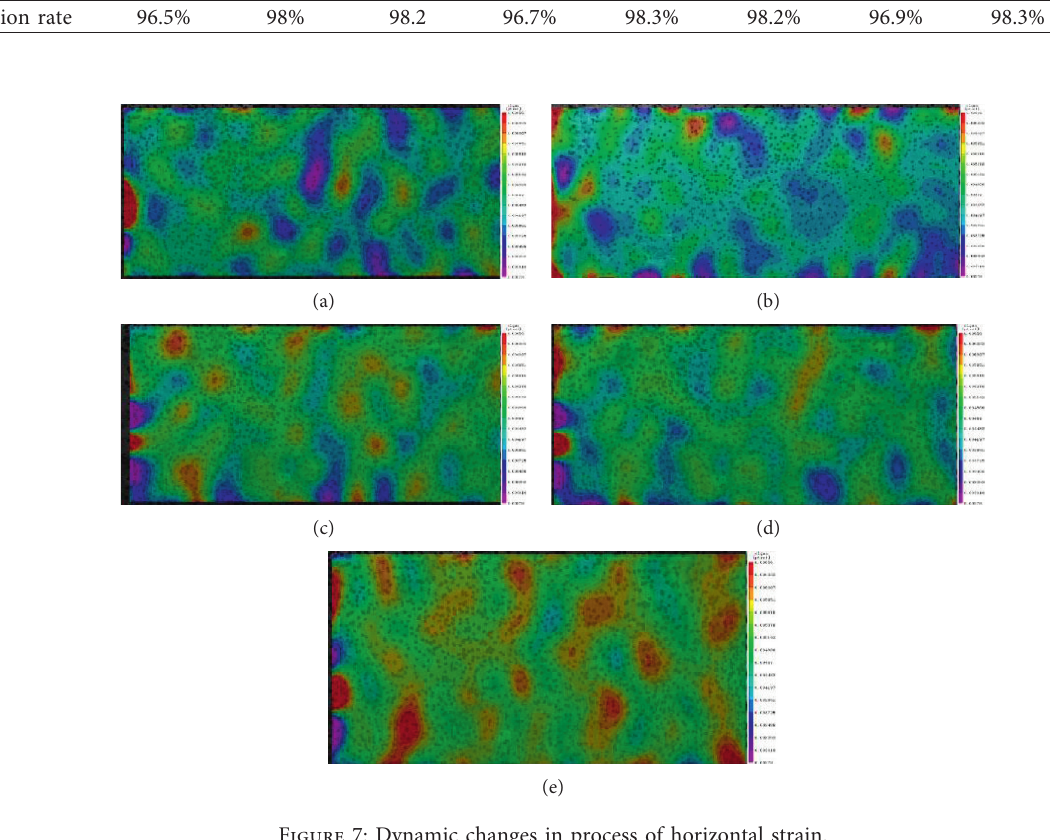
Figure 7: Dynamic changes in process of horizontal strain.